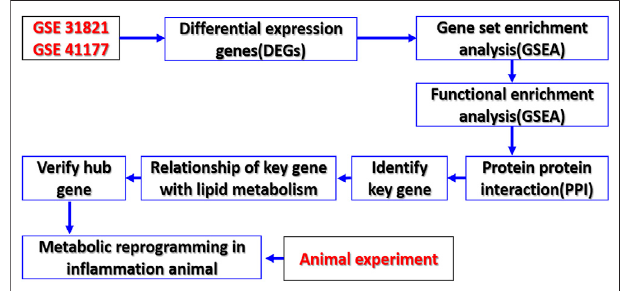
FIGURE 1 | Study fl owchart. Sequencing data from AF patients and controls in GSE 31821 and GSE 41177 datasets were analyzed